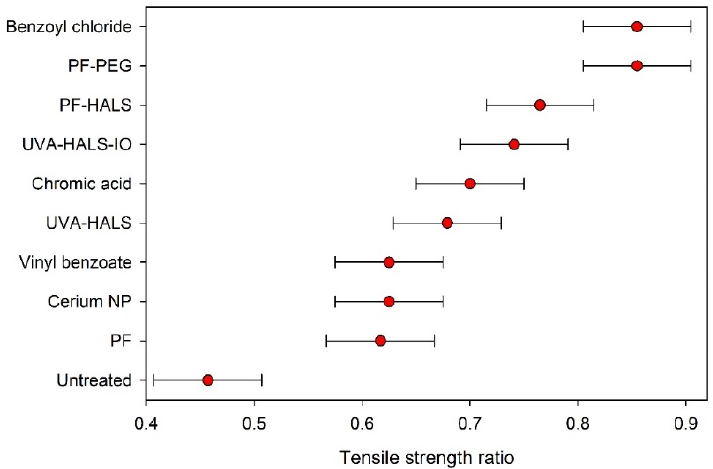
Figure 2. Tensile strength losses of treated yellow cedar veneers exposed outdoors for 35 days.